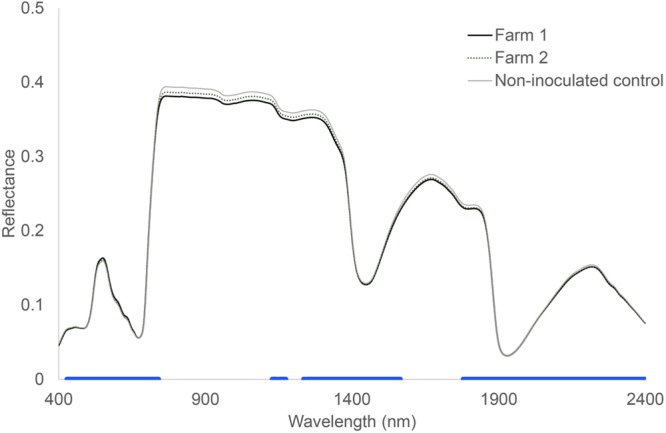
Hyperspectral reflectance of Triticum aestivum L. plants growing in soils inoculated with microorganisms from two different farms. The blue bar at the bottom indicates where there were no significant differences between control soil and both the inoculated soils. Wilcoxon test, P < 0.05, n = 24.